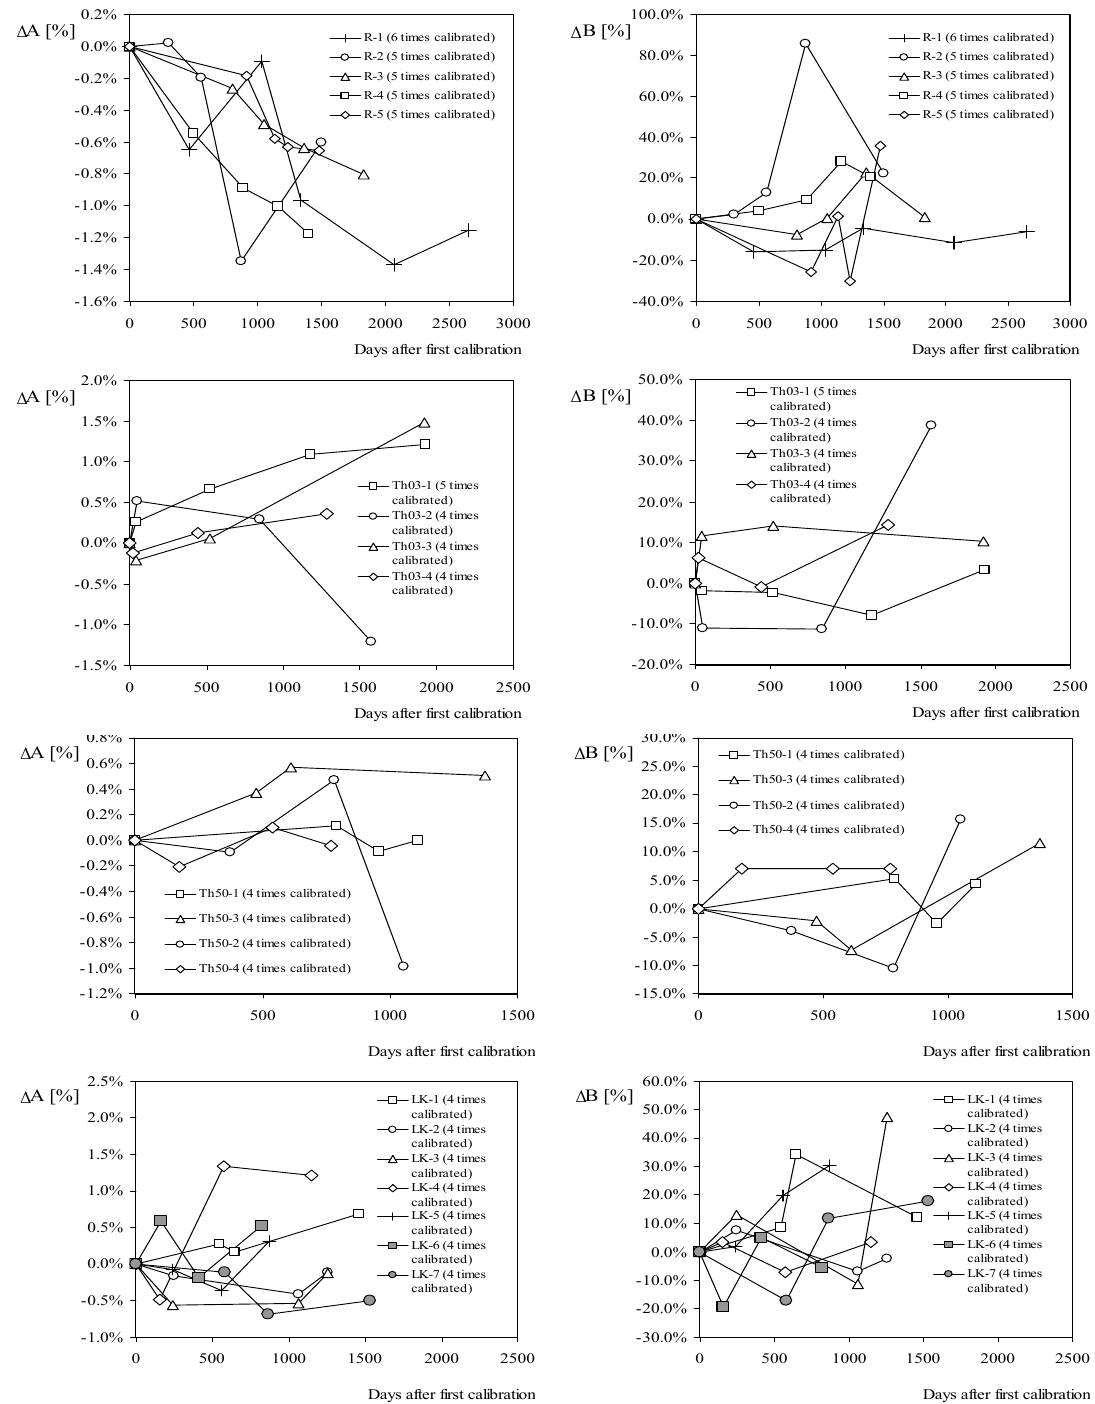
Figure 9. Percentage variation of calibration constants A and B from the initial values with regard to (from top to bottom): five specific Risø P2546 anemometers (R-1 to R-5) calibrated more than four times; four specific Thies Clima 4.3303 anemometers (Th03-1 to Th03-4) calibrated more than three times; four specific Thies Clima 4.3350 anemometers (Th50-1 to Th50-4) calibrated more than three times; and seven specific Vector Instruments A100 LK anemometers (LK-1 to LK-7) calibrated more than three times. All anemometers calibrated at the IDR/UPM